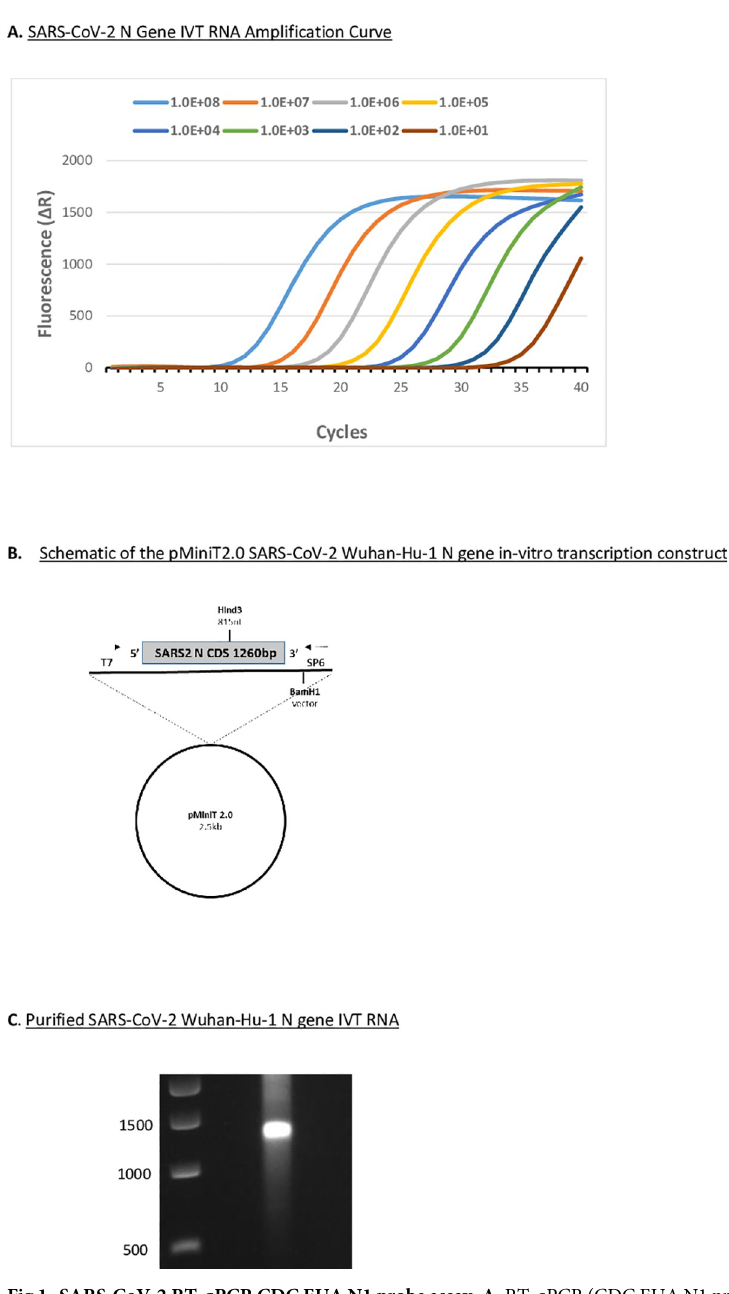
Fig 1. SARS-CoV-2 RT-qPCR CDC EUA N1 probe assay. A. RT-qPCR (CDC EUA N1 probe assay) targeting SARS-CoV-2 Wuhan-Hu-1 N gene in vitro transcribed (IVT) RNA. Log dilution series of N gene IVT RNA ranging from 10 8 to 10 copies of the N gene underwent reverse transcription. Fluorescence data were collected and processed using a 40 cycle cut-off on an AriaMx Real-Time PCR System. B. Schematic of the pMiniT2.0 SARS-CoV-2 Wuhan- Hu-1 N gene in vitro transcription construct with T7 RNA polymerase promoter driving full-length (1260 nt) N gene RNA production. C. DNase-treated and purified SARS-CoV-2 Wuhan-Hu-1 N gene IVT RNA on a non-denaturing 1% agarose gel stained with ethidium